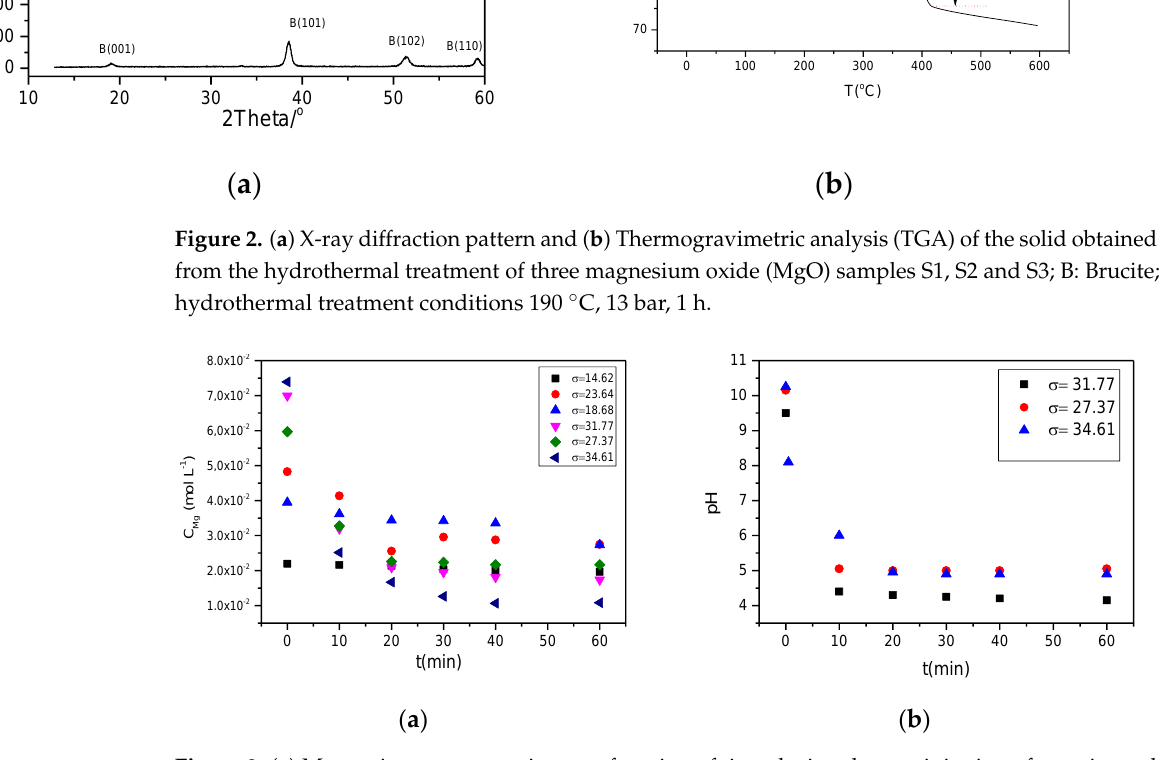
Table 2. Precipitation of struvite in its supersaturated solutions (Method A). Initial pH, magnesium concentration, C Mg , relative supersaturation, σ struvite , and initial precipitation rate, R s . 25 ◦ C. [Mg] tot = [N-NH 3 ] tot = [P] Exp. pH initial